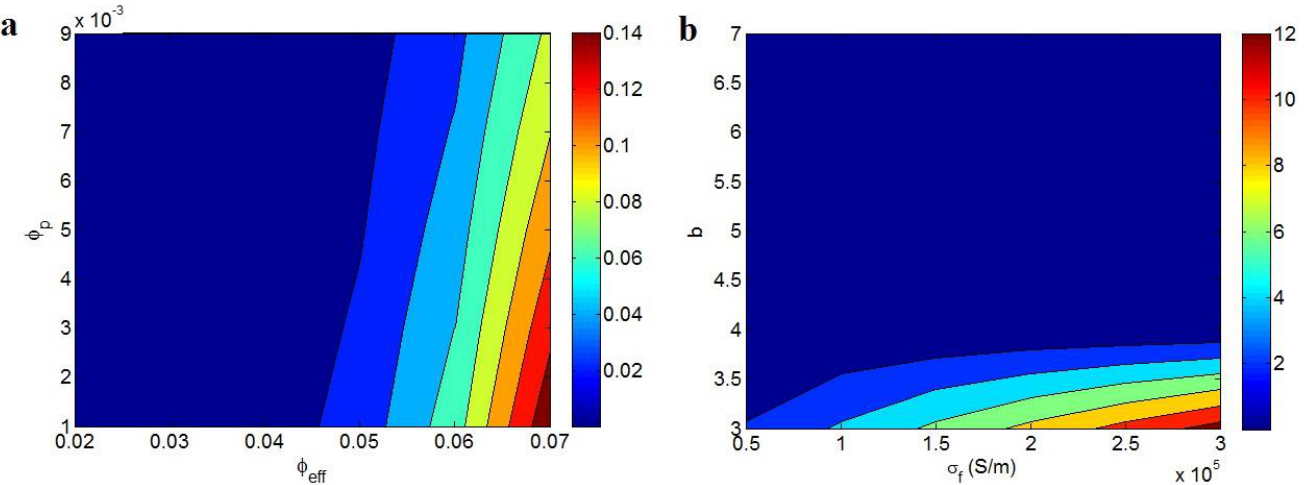
Figure 1. Two-dimensional plots showing the estimates of conductivity using Equation (9) at ( a ) various ranges of “ φ ef f ”and “ φ p ” ( σ f = 10 5 S/m and b = 5) and ( b ) different levels of “ σ f ” and “b” ( φ ef f = 0.04 and φ p = 0.005).